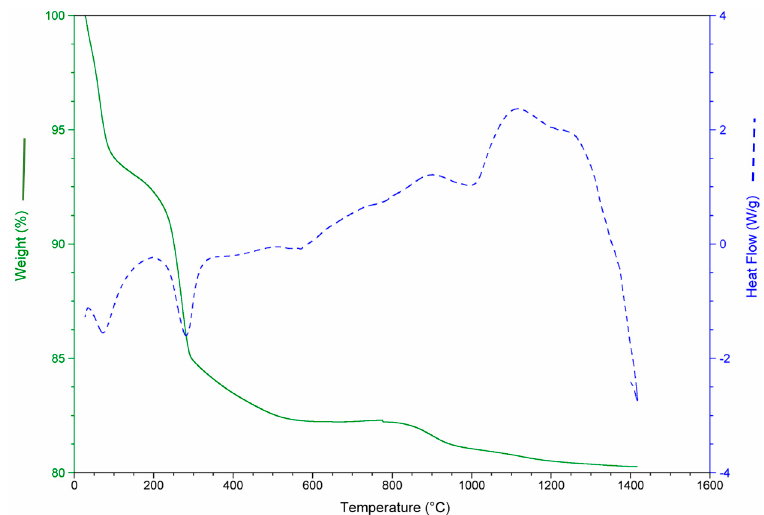
Figure 4. Mass loss and heat flow of aquiculture industry (MS).